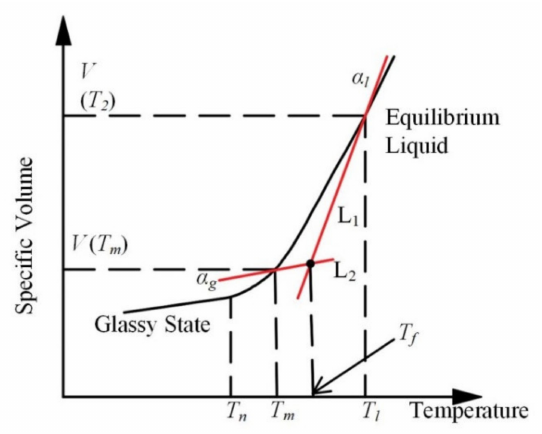
Figure 4. Structural relaxation phenomenon of viscoelastic glass material